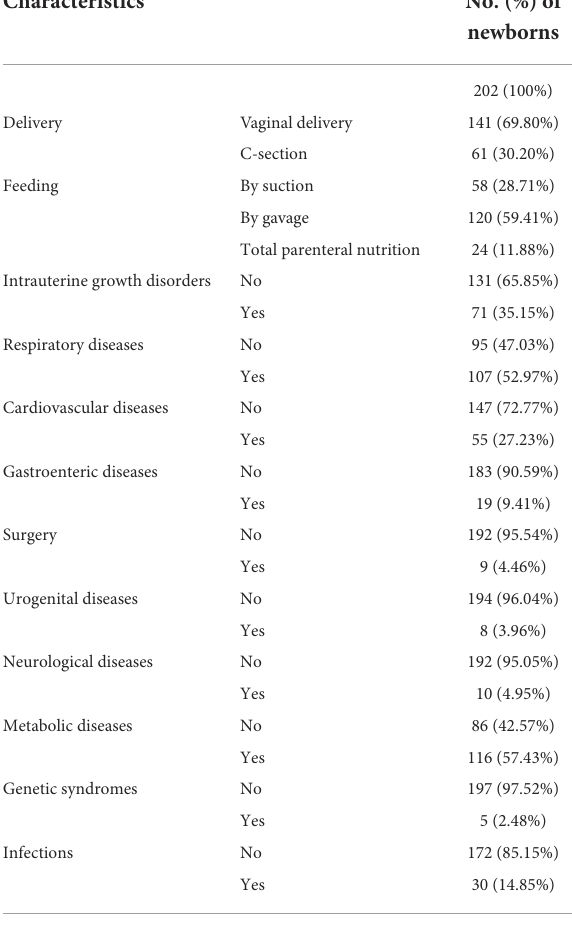
TABLE 4 Clinical characteristics of the sample population at the time of NAME assessment. Characteristics